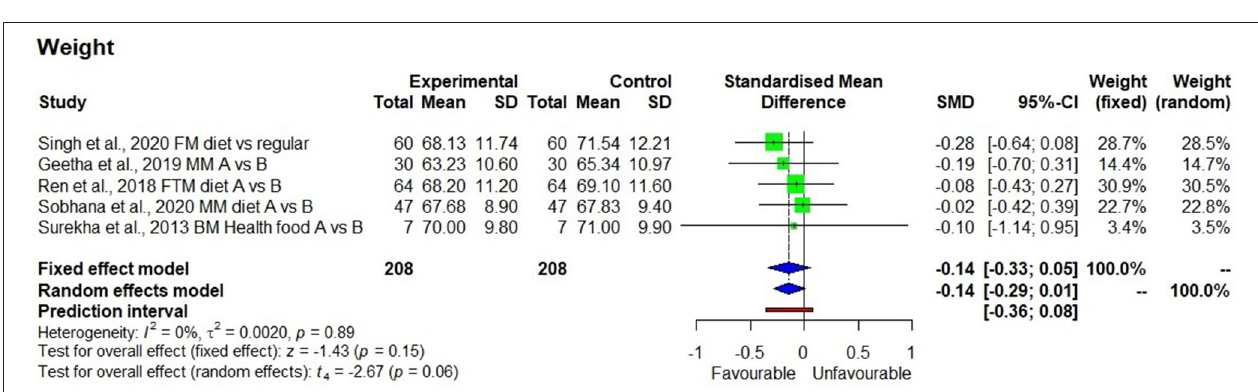
FIGURE 7 | Effect of consuming millets on weight of the participants (pre- vs. post-treatment or intervention vs. control